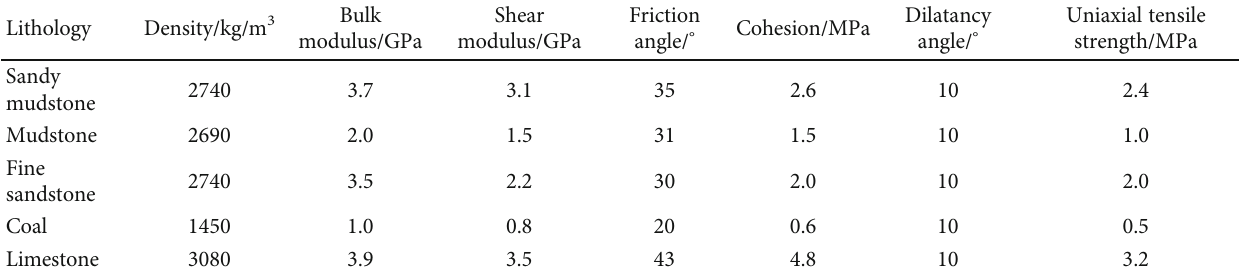
Table 2: Mechanical parameters of coal and